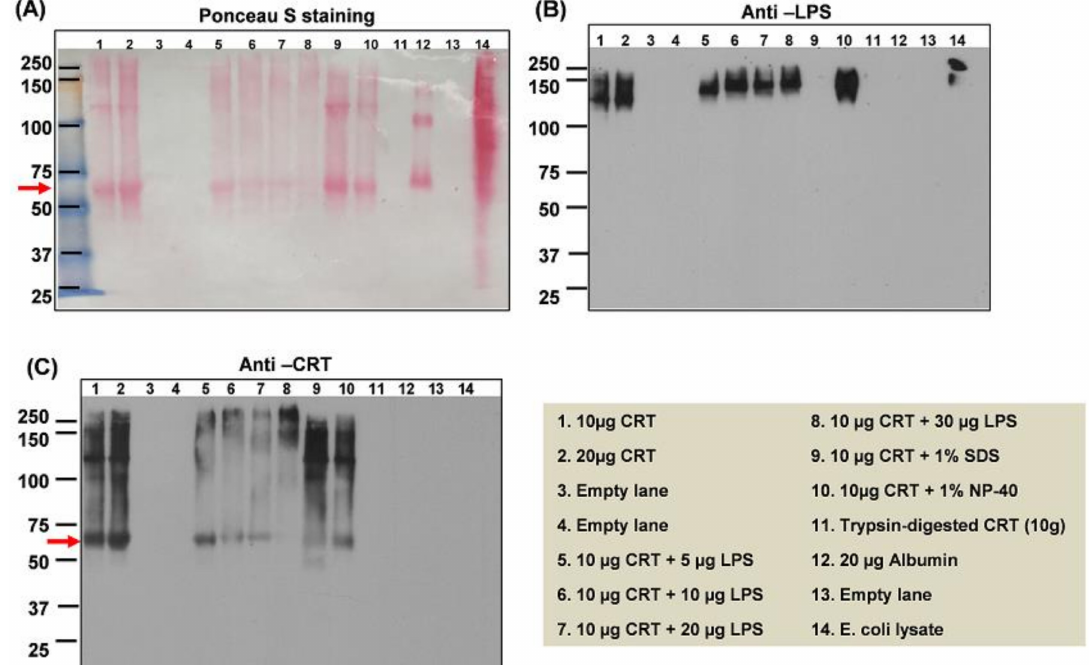
Figure 2. Immunoblot showing that LPS binds only to multimeric/oligomerized CRT and induces its oilgomerization. Recombinant CRT (rCRT) was mixed with increasing concentrations of LPS overnight at 4 ◦ C, or 1% sodium dodecyl sulfate (SDS), 1% NP40, or trypsin (1:60 w / w ) at 37 ◦ C for 4 h. The samples were subjected to native gel electrophoresis followed by immunoblot analysis with anti-CRT or anti-LPS. ( A ) Ponceau Red; ( B ) anti-LPS; ( C ) anti-CRT. Increasing concentrations of LPS appear to induce multimeric forms of CRT while decreasing the CRT monomer (A and C, lanes 5–8). At 10 µ g of CRT and 30 µ g of LPS, there is little to no monomer remaining (A and C, lane 8). The detergents, 1% SDS (A and C, lane 9) and 1% NP-40 (A and C, lane 10) prevents CRT oligomerization. LPS remains bound to CRT in the presence of NP-40 but not in the presence of SDS, which removes all LPS from CRT (B, lane 9). Trypsin completely digested CRT (lane 11). LPS is only detected in high molecular weight aggregates of CRT (from ~130–240 kDA; lanes, 1, 2, 5–8, 10, 14). Specificity of the antibodies is ensured by the lack of detection of LPS (B, lane 12) or CRT (C, lane 12) with either antibody. The antibody to LPS only reacted with a high molecular weight form of LPS in the E. coli lysate (B, lane